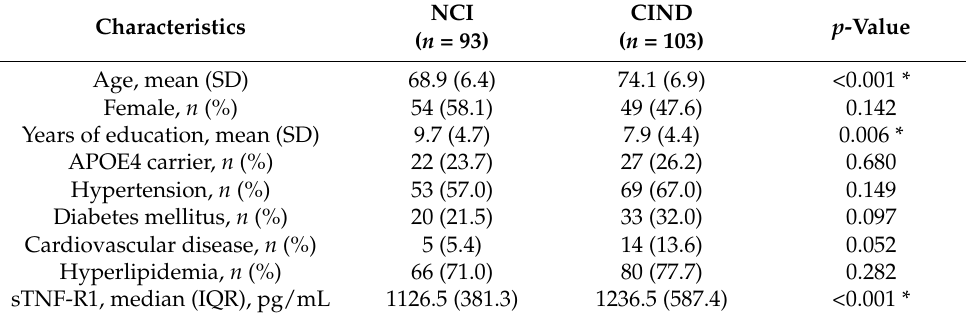
Table 1. Demographic characteristics of cases and controls at baseline.